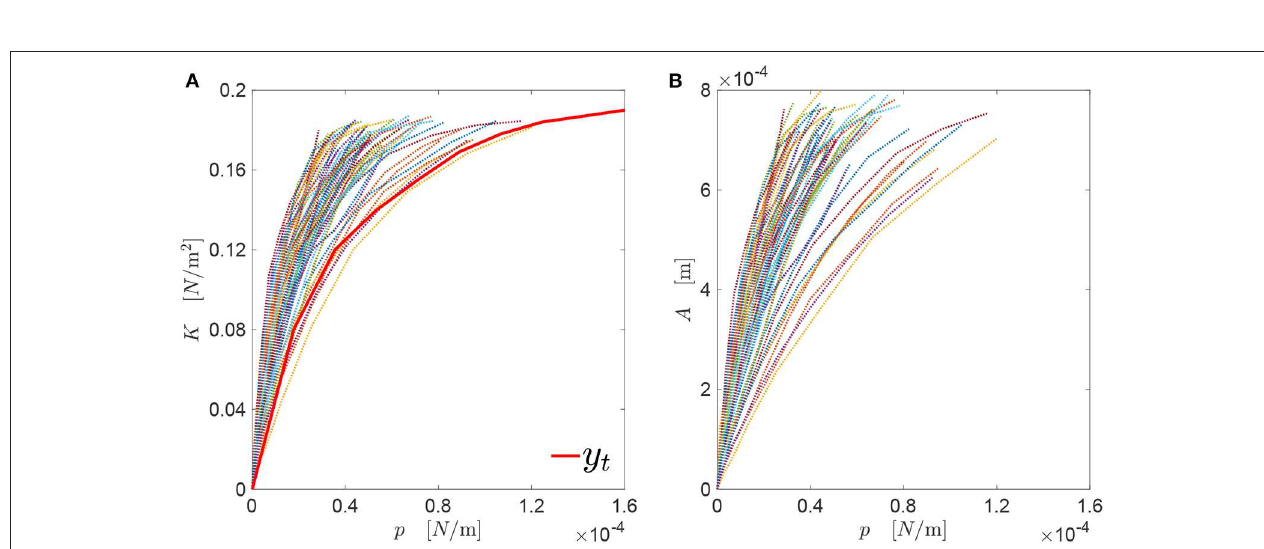
FIGURE 5 | Genome database: (A) enumeration of all the pairs H and γ generated. (B) First thirteen elements of the first three columns of the matrix 8 ( M which are common to each combination. A larger number of phases is considered for smaller values of γ (i.e., for γ < 1.6).